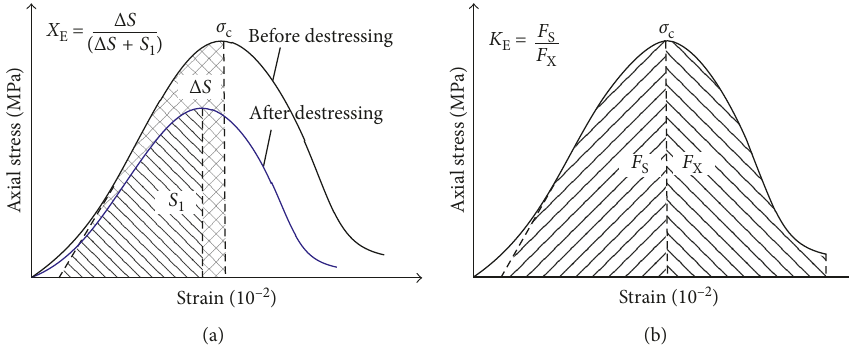
K E and E . (a) Calculation of